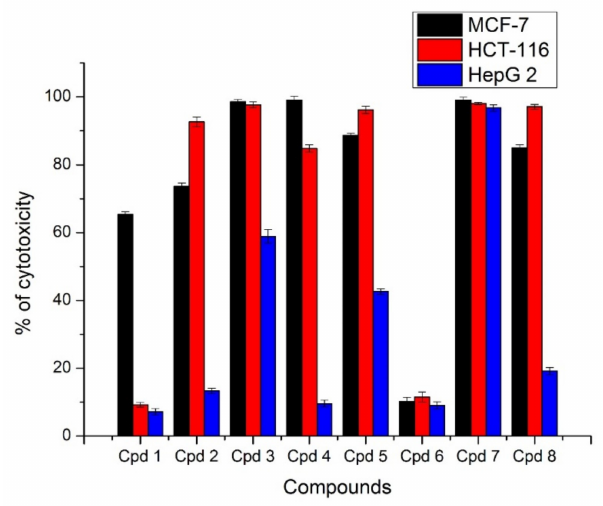
Figure 2. In vitro cytotoxic activity of compounds 1 – 8 at concentration 10 µ g/mL against different cancer cell lines. The results are represented as % inhibition ± standard deviation. Each result is the mean of three replicates.